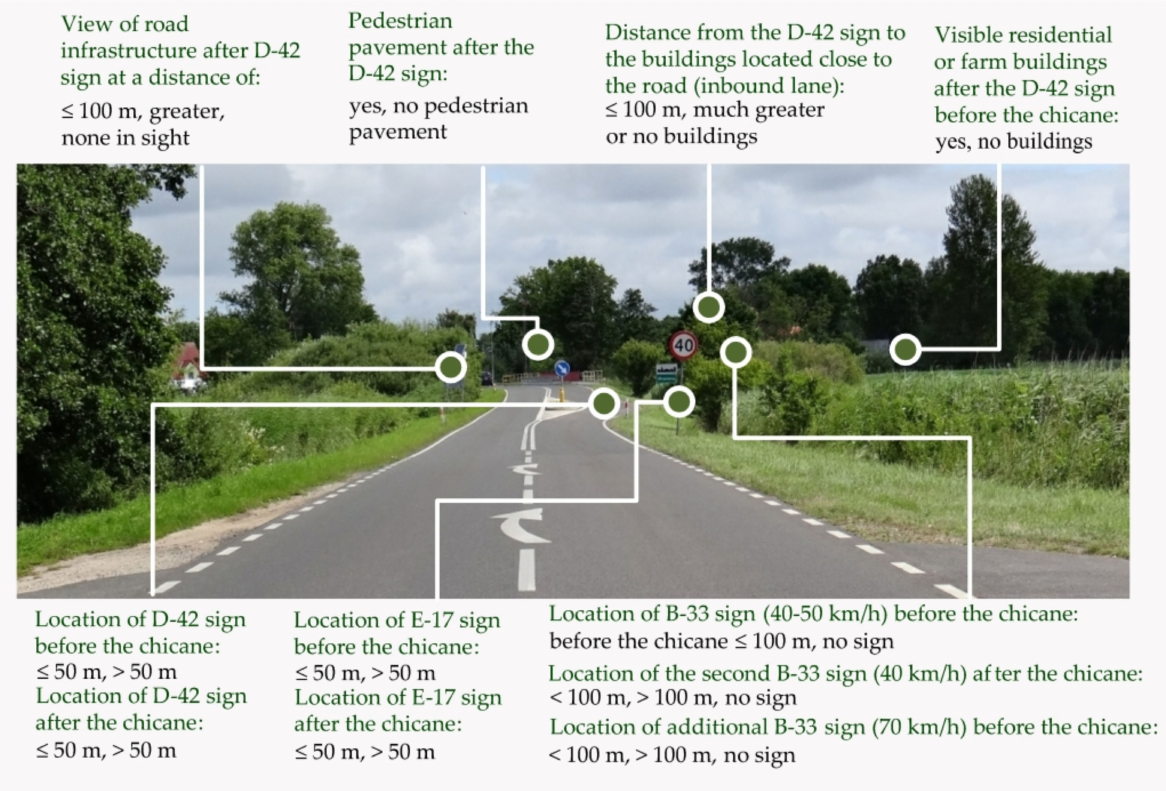
Figure 8. Factors selected for the analyses, along with the assigned quantitative measures related to traffic management scheme, against the background image of test section No. 2. Green font designates qualitative factors and black font designates the adopted interpretation of the quantitative